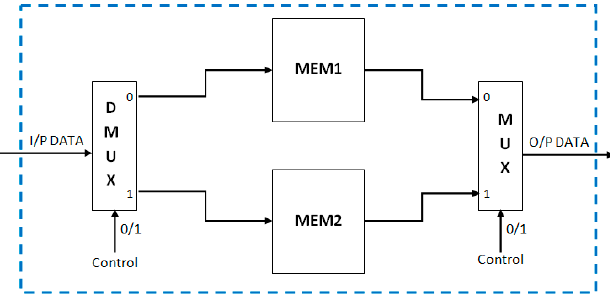
Figure 7. VLSI architecture for input buffer memory.